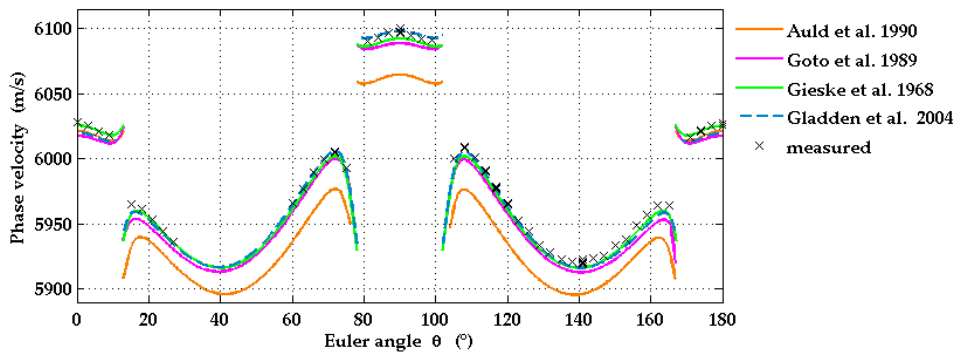
Figure 5. Theoretical dependencies of SAW phase velocities on wavevector direction for r-plane sapphire (solid and dashed lines) calculated using different sets of elastic constants taken from the literature (see Table 3), and compared with experimental data (black crosses).